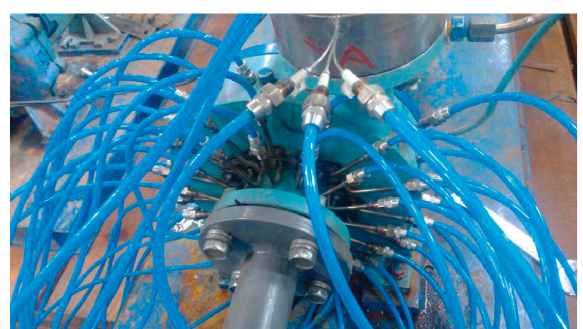
Figure 4: Pressure test unit of centrifugal pump.